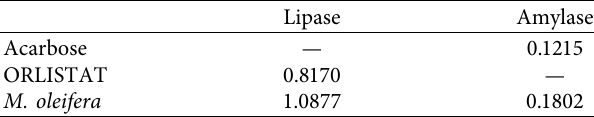
Figure 2: Efect of M. oleifera leaf extract on α -amylase activity. Table 4: Amylase and lipase IC 50 values of M. oleifera